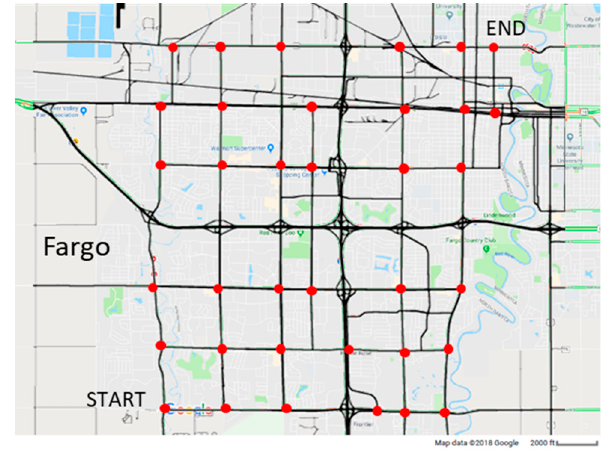
Figure 6. A water distribution network case study.